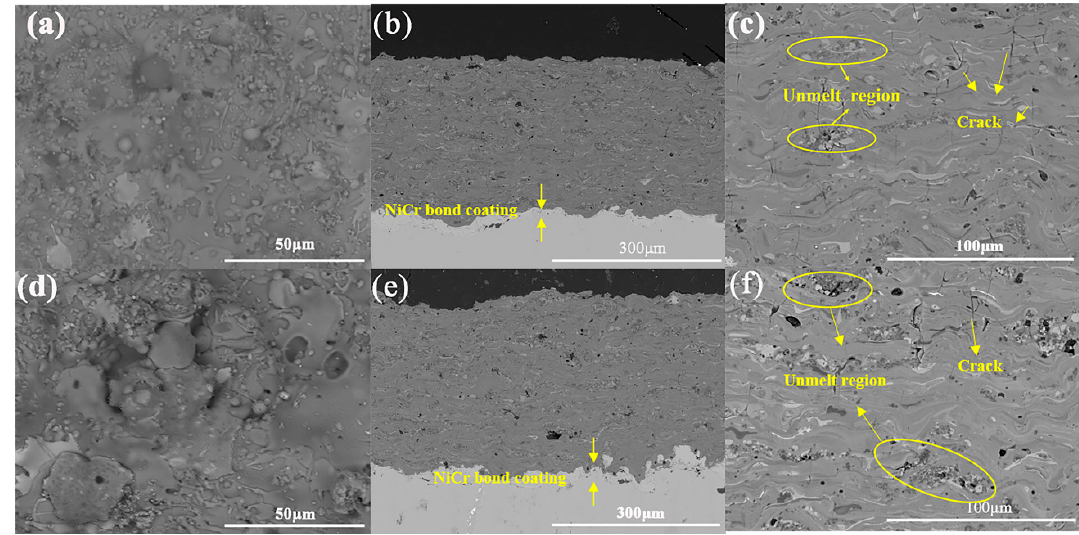
Figure 10. The cross-section and surface morphologies of the ceramic coatings ( a – c ) coating 1; ( d – f ) coating 2.